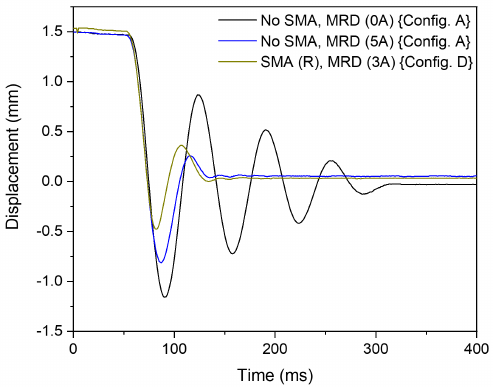
Figure 15. The mass displacement versus time allowing for the comparison of shock damping performance of individual SMA and MR dampers and combined SMA–MR